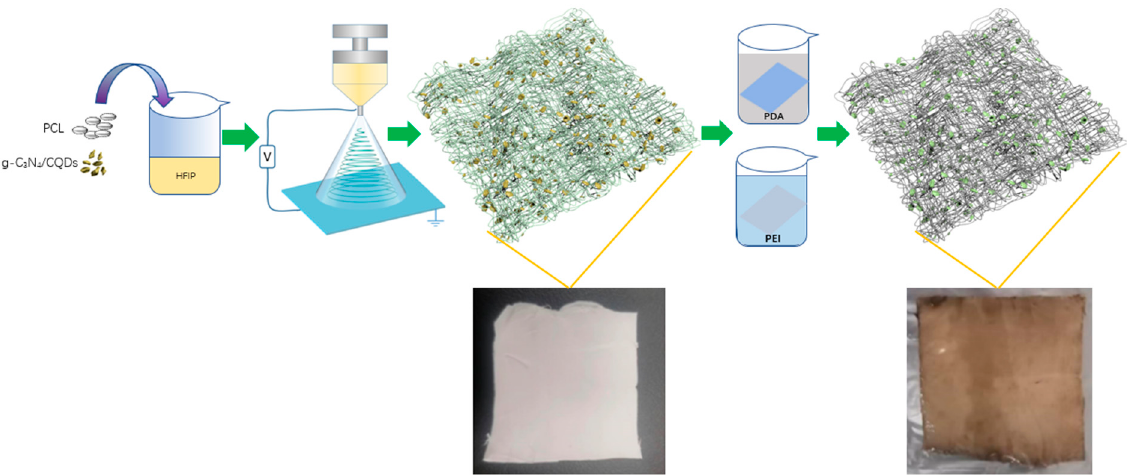
Figure 1. The schematic illustration of the fabrication of modified PCL-g-C 3 N 4 / CQDs electrospun membranes.